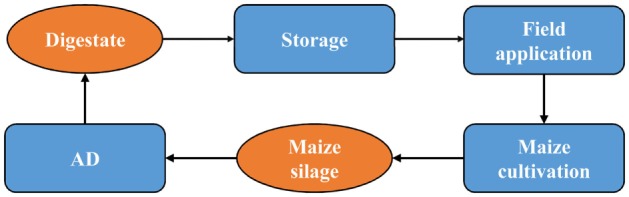
Maize silage cycle.